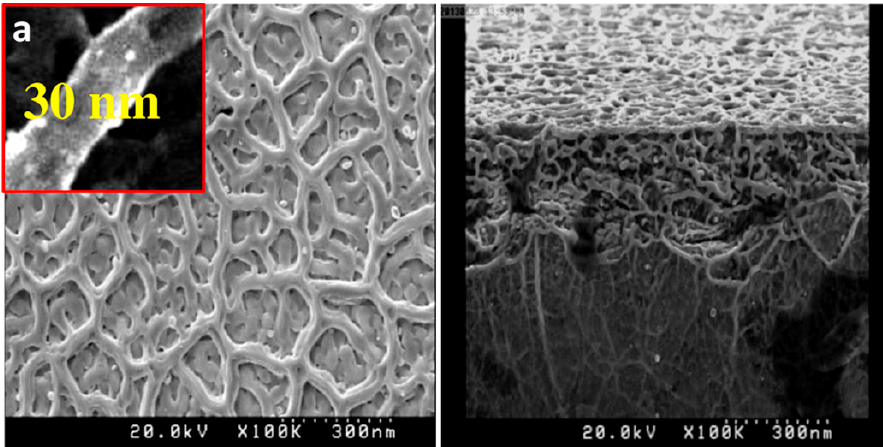
Figure 3. Scanning electron microscopic (SEM) images of the spray pyrolysis deposited (SPD) TiO 2 coating containing nanofibers. Inset ( a ) shows the fiber size is around 30 nm. The substrate temperature was 350 °C. Reprinted with permission from [78], © 2015, Elsevier GmbH.